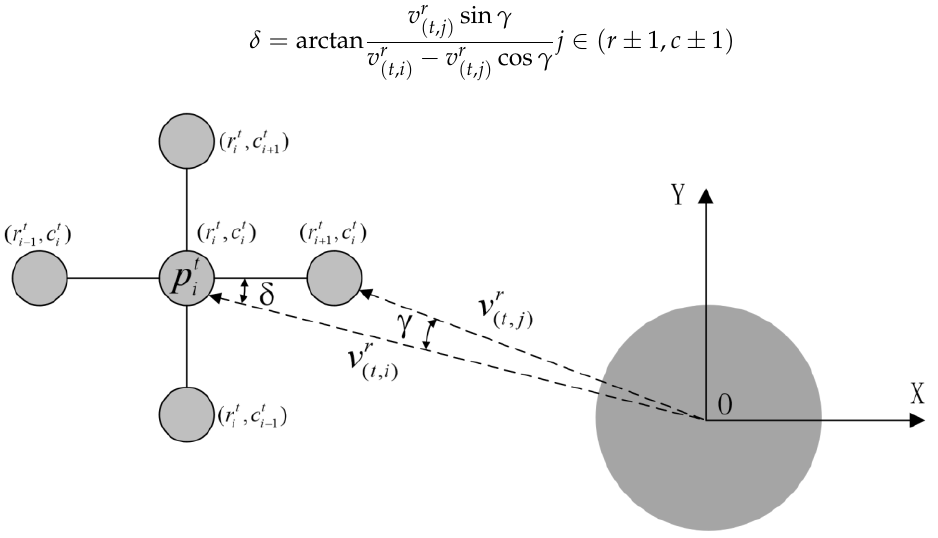
Figure 5. Point cloud search.